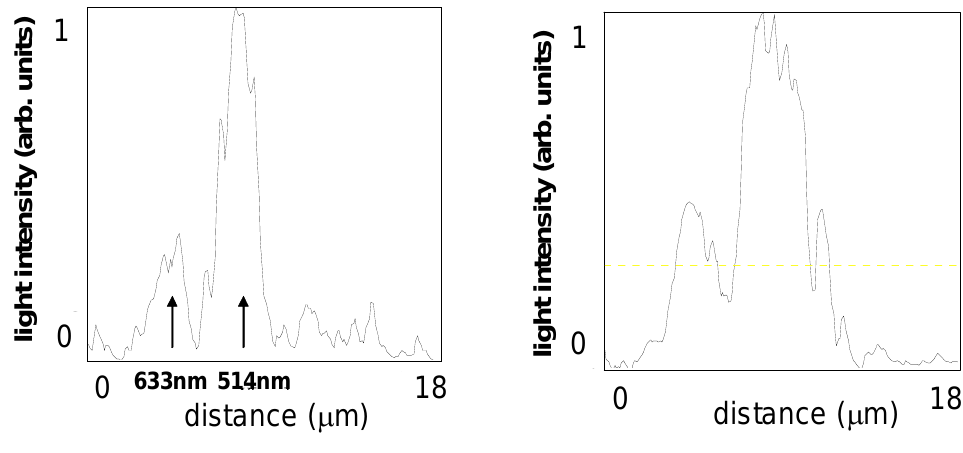
Figure 7. Cross sections of the optical microscope images along the yellow lines shown in Figure 6. Individual spectral lines are clearly resolved in the left plot obtained using 514 nm and 633 nm illumination. Multiple spectral lines are visible in the right plot, which is obtained under multiline